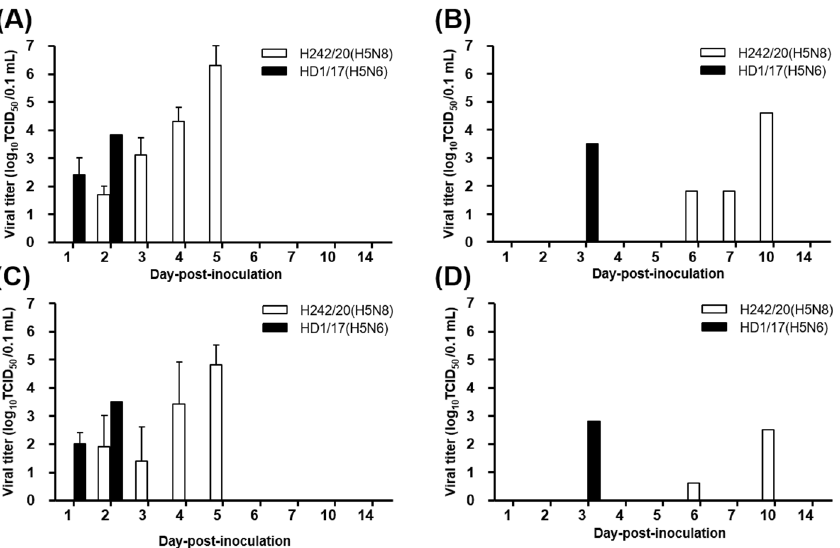
Figure 1. Virus isolation from oropharyngeal (OP) ( A , B ) and cloacal (CL) ( C , D ) swab samples of virus- exposed chickens. Five chickens were intranasally inoculated with 10 6 EID 50 /0.1 mL H242/20(H5N8) or HD1/17(H5N6) ( A , C ). For the contact group, three chickens were co-housed with H242/20(H5N8) or HD1/17(H5N6)-infected chickens ( B , D ). Viral titers are shown as the mean ± standard